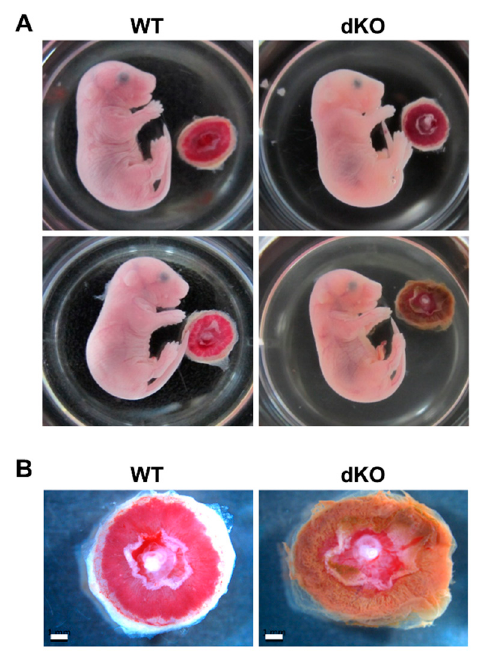
Figure 4. Embryo and placenta from pregnant WT and Stab1 / 2 dKO mice. ( A ) WT and Stab1 / 2 dKO embryos at E17.5 and associated placentas. ( B ) High-magnification images of the placentas derived from WT and Stab1 / 2 dKO mice. Scale bar, 1 mm; n = 3.